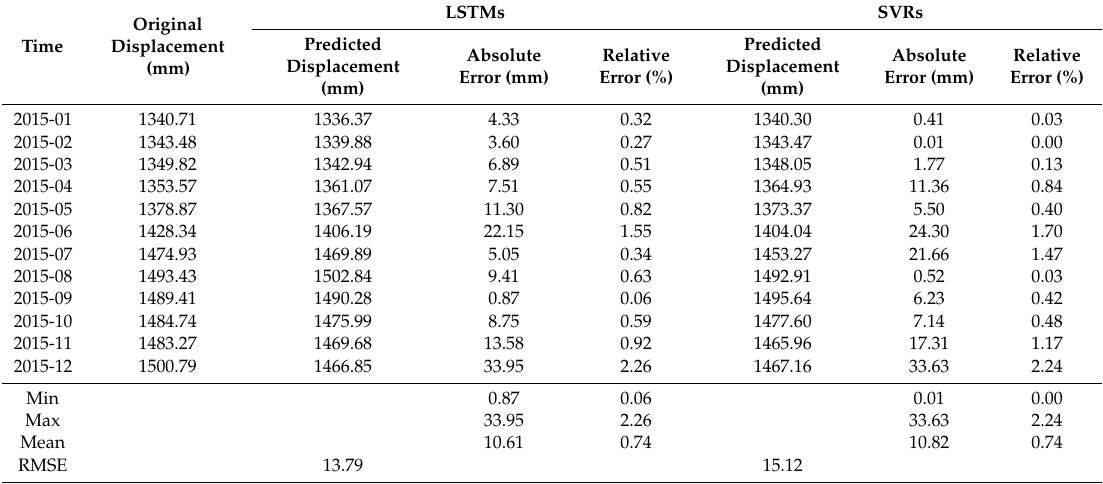
Table 4. Accuracy of the predicted displacement with the LSTM and SVR models of